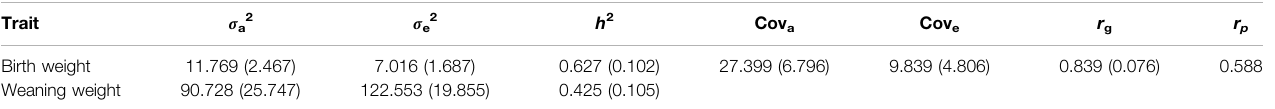
TABLE2| Estimatesofvariance(covariance)components,heritabilities,andgeneticcorrelationandtheirstandarderrors(inbrackets)undertwo-traitmodelsusingthe410K marker set and expected dosage-based G matrix. Trait